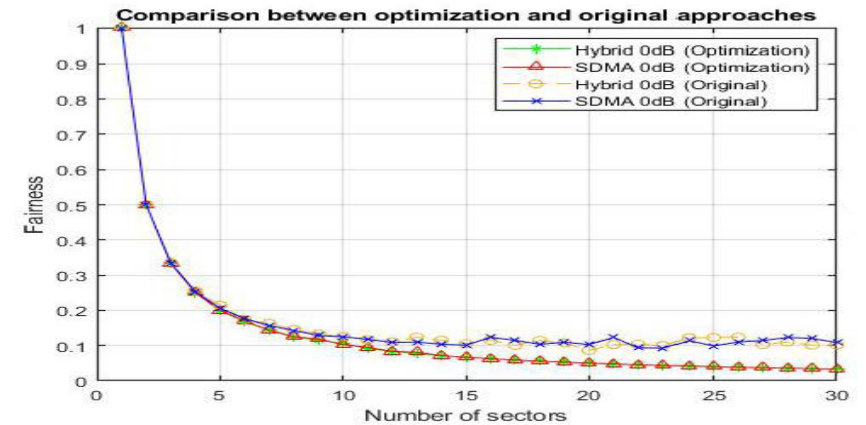
Figure 7. Fairness: comparison between optimization and original approaches.